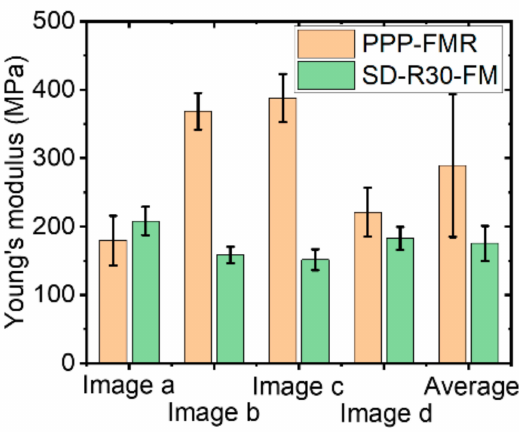
Figure 12. Young’s modulus of an LDPE sample with different AFM tip